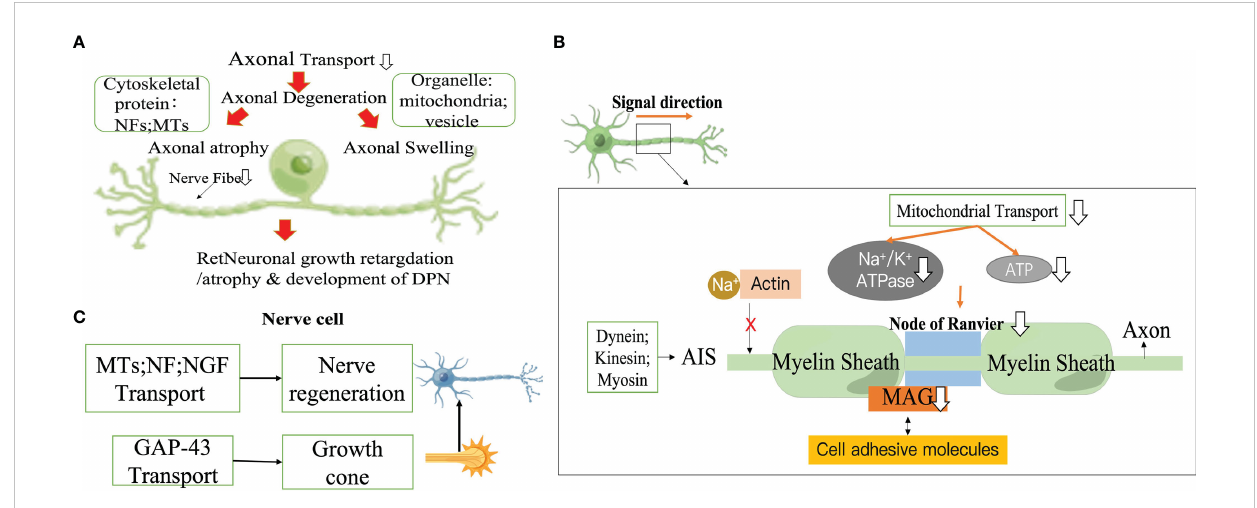
FIGURE 2 Impaired axonal transport promotes DPN progression. (A) Axonal degeneration. (B) Action potential drop. (C) Impaired nerve regeneration. NF, neuro fi lament; MT, Microtubule; MAG, Myelin associated glycoprotein; AIS, Axon initiation segment; NGF, Neurotrophic